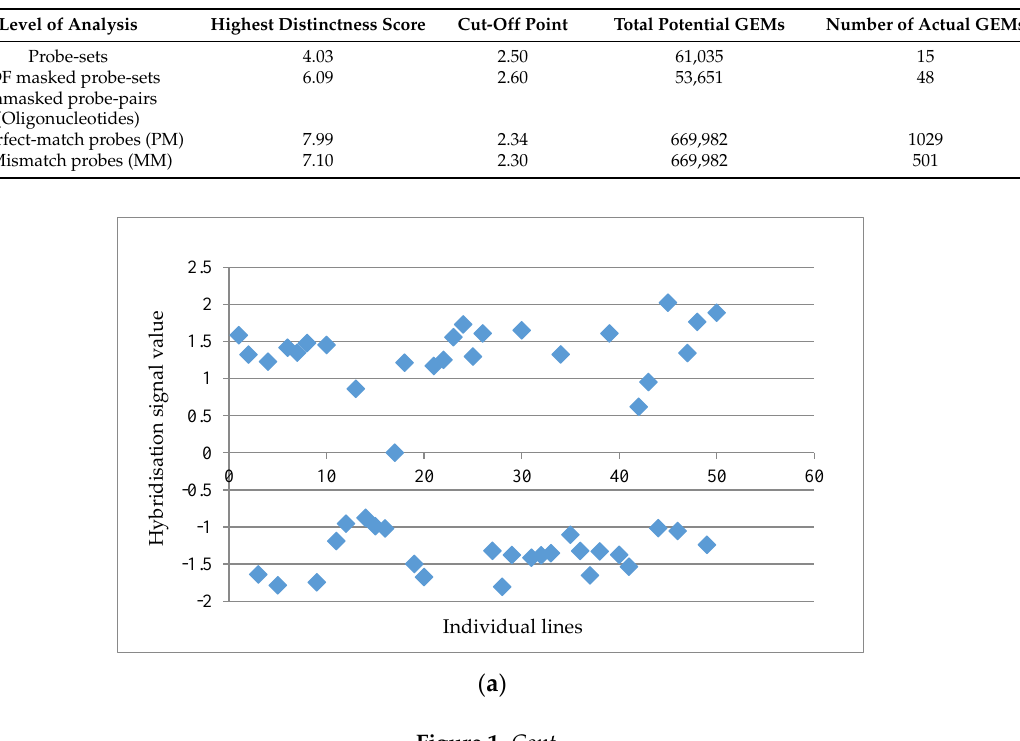
Table 1. A summary of gene expression markers (GEMs) development at three different levels: